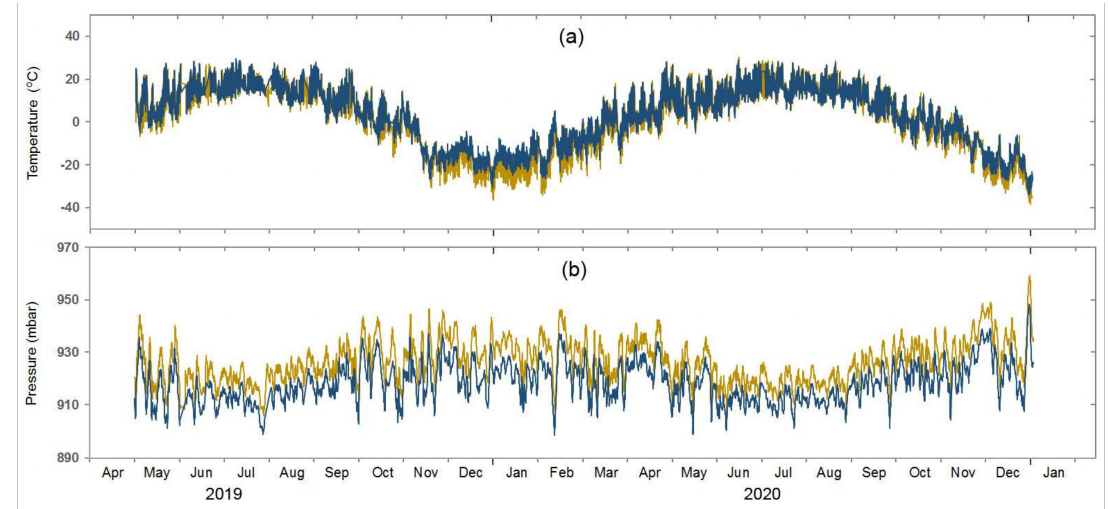
Figure 2. Comparison of changes in temperature ( a ) and atmospheric pressure ( b ) from 1 May 2019 to 31 December 2020 at the BADG observation point (blue graphs) and at the Kyren weather station (yellow graphs) located at a distance of 11 km from the